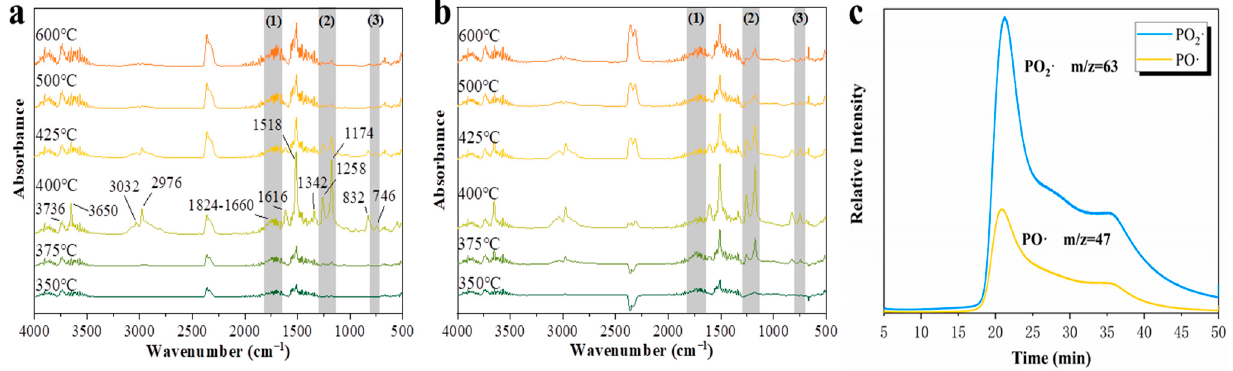
Figure 6. FTIR spectra of volatile pyrolysis products of EP ( a ) and 2%HPDAl/EP ( b ) at different temperatures, TG-FTIR-GC/MS curves of PO· and PO 2 · from HPDAl ( c ).